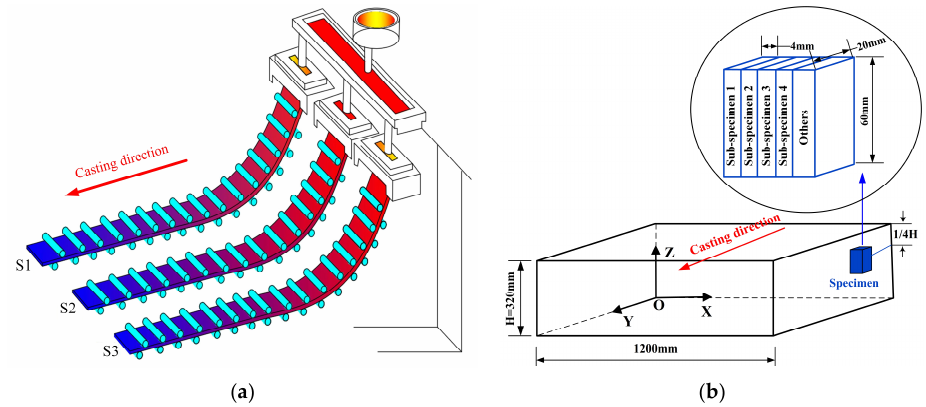
Figure 1. Schematic diagram of experimental material sampling. ( a ) the schematic of casting strands; ( b ) the schematic of specimen from a casting strand.